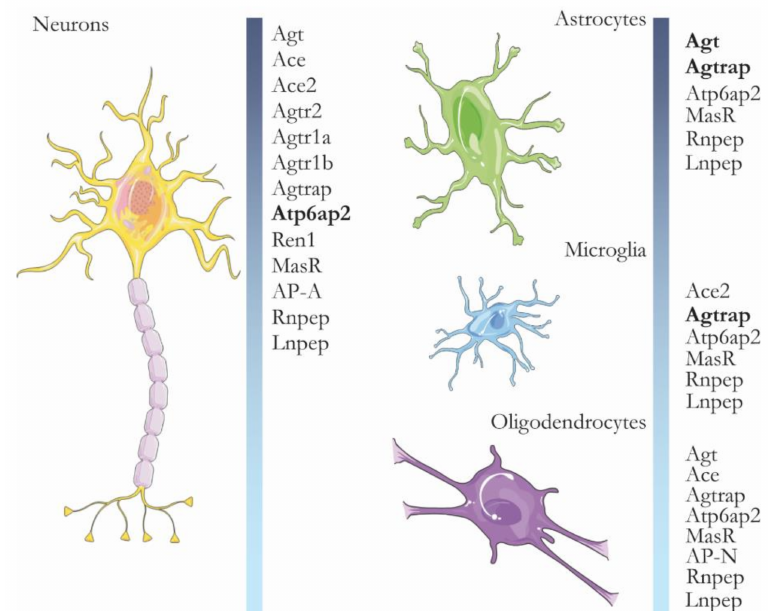
Figure 1. Genes of the RAS system in mouse brain cells. The figure shows genes expressed in the main cell types of the mouse brain, obtained by single-cell sequencing. Genes in black show increased expression (both copy number and number of expressing single cells) in that cell type.